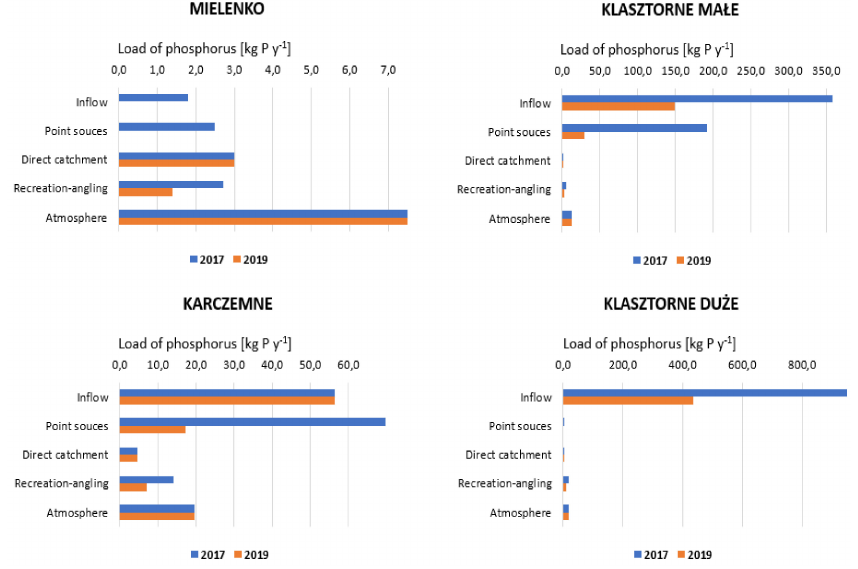
Figure 3. Annual load of phosphorus (P) (kg P y -1 ) entering to Kartuzy lake